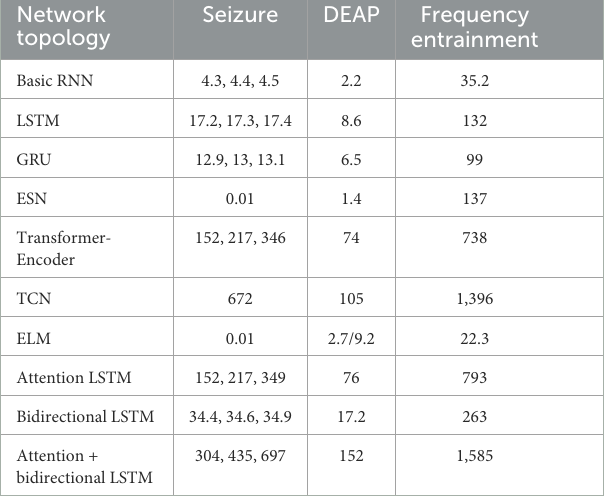
TABLE 6 Model parameters for each architecture and dataset in